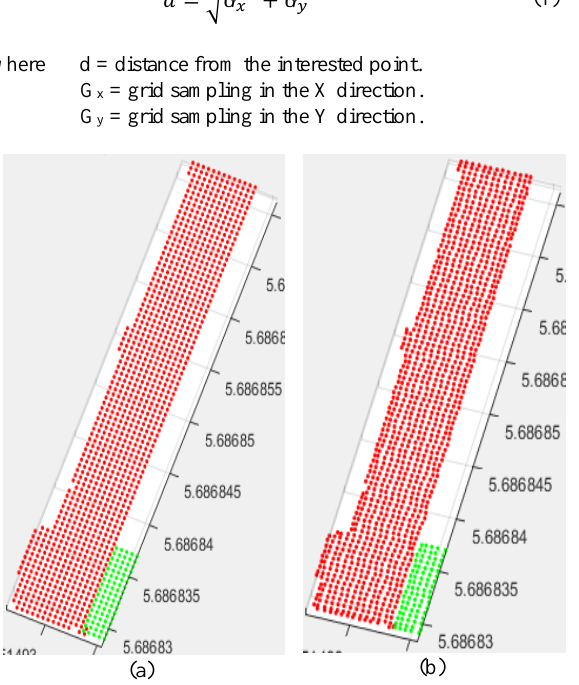
Figure 3. a) 3D regular grid points, b) 3D means